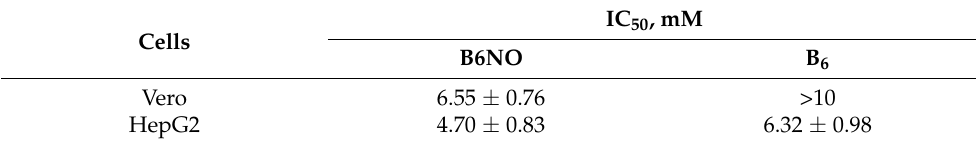
Table 1. Dose IC 50 values for normal and tumor cells after 24 h of exposure to B6NO and vitamin B6.